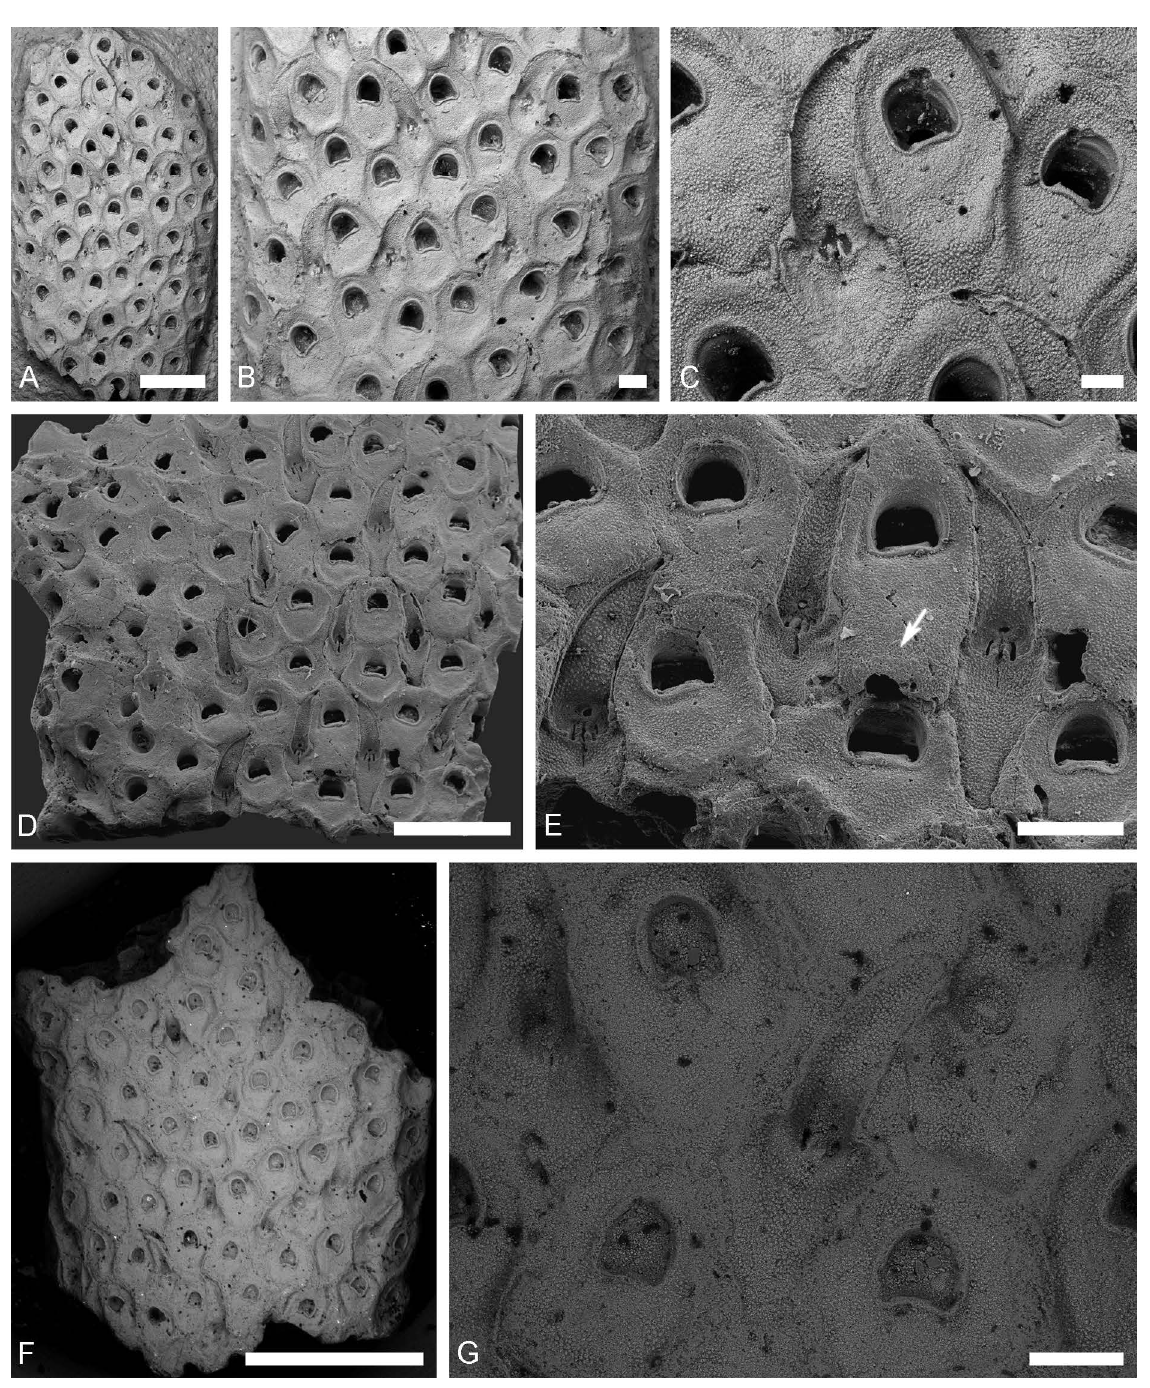
Fig. 9. Rhagasostoma angliae Brydone, 1936. A–C . SM B36671, Middle Campanian ( Belemnitella mucronata Zone), Weybourne, Norfolk, England, UK. A . Overview of erect bifoliate colony. B . Non- ovicellate autozooids and avicularia. C . Opesiae of non-ovicellate autozooids with distal shelf and avicularium. D–E . SMF 29914, Late Campanian of Vigny, Île-de-France, France. D . Overview of erect bifoliate colony. E . Non-ovicellate and one ovicellate (with partially broken ooecium, arrowed) autozooids and avicularia. F–G . SMF 26288, early Maastrichtian of Hemmor, Germany. F . Overview of erect bifoliate colony. G . Non-ovicellate autozooids and avicularia. Scale bars: A, D = 1 mm; B, G = 200 µm; C = 100 µm; E = 300 µm; F = 2